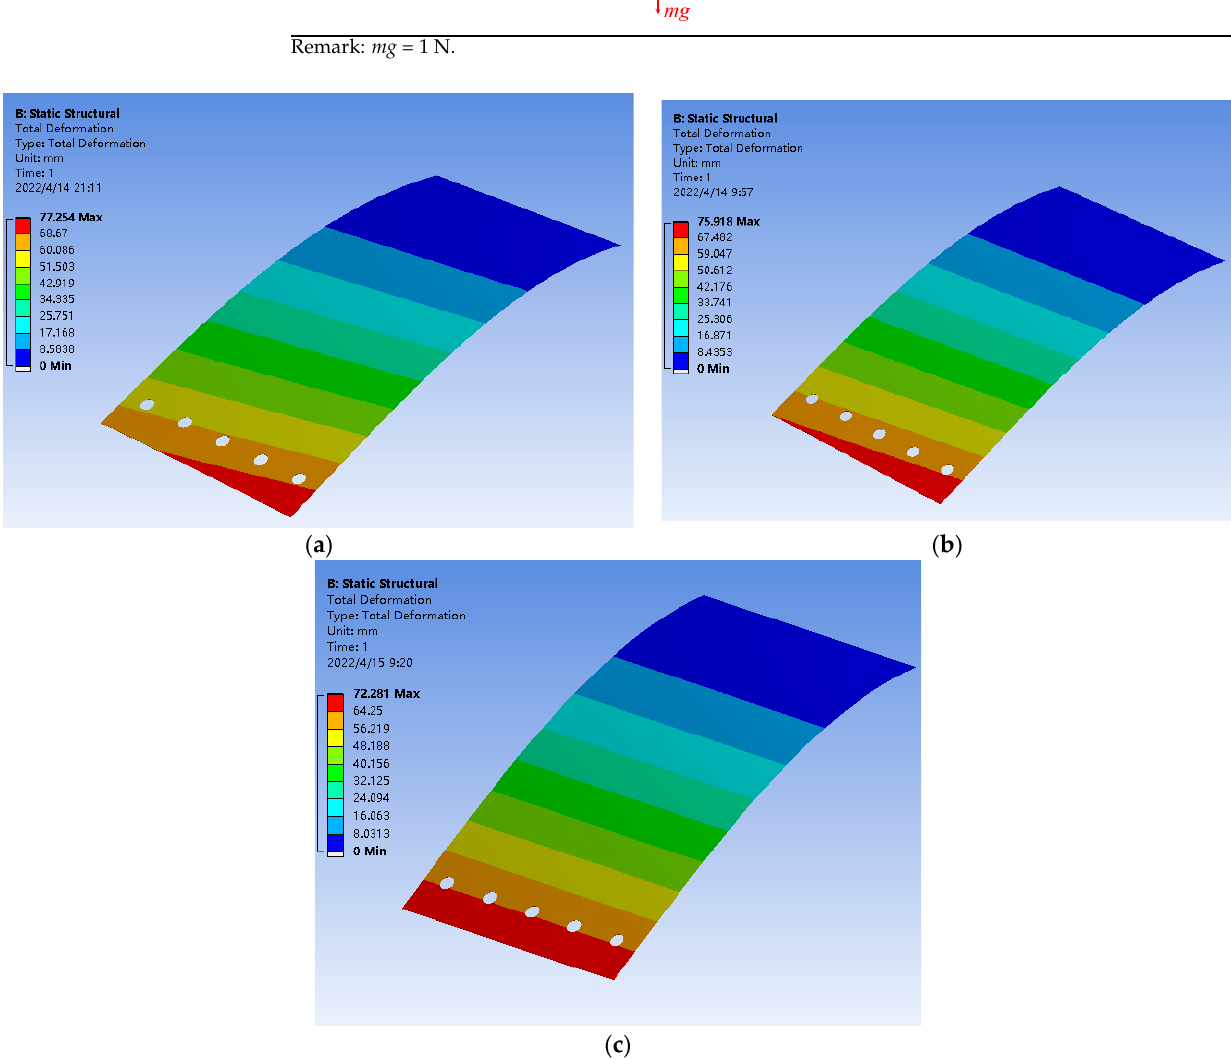
Figure 14. Finite element simulation results of the FLS under different loading conditions. ( a ) Case 1; ( b ) Case 2; ( c ) Case 3.